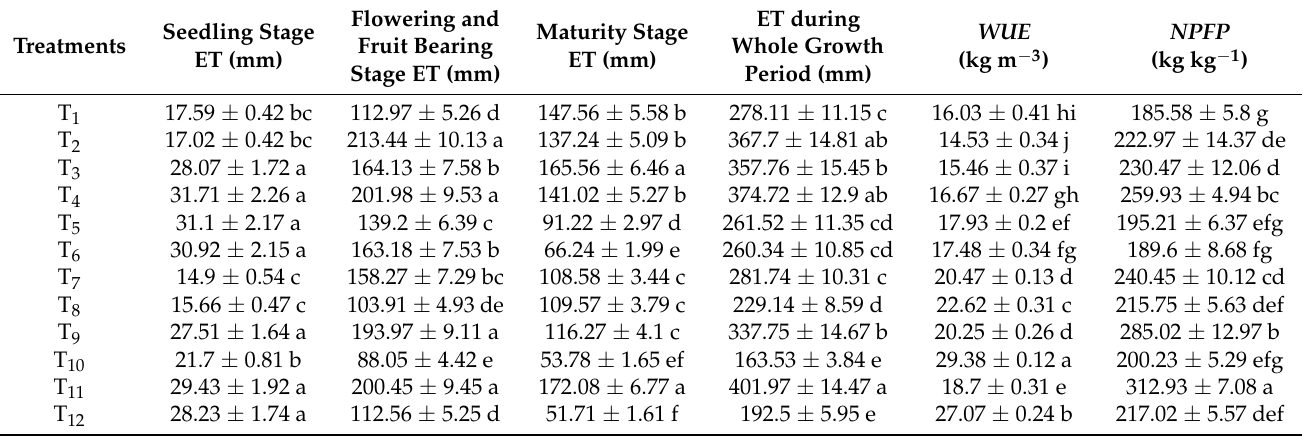
Table 4. The crop water consumption and nitrogen utilization rate of